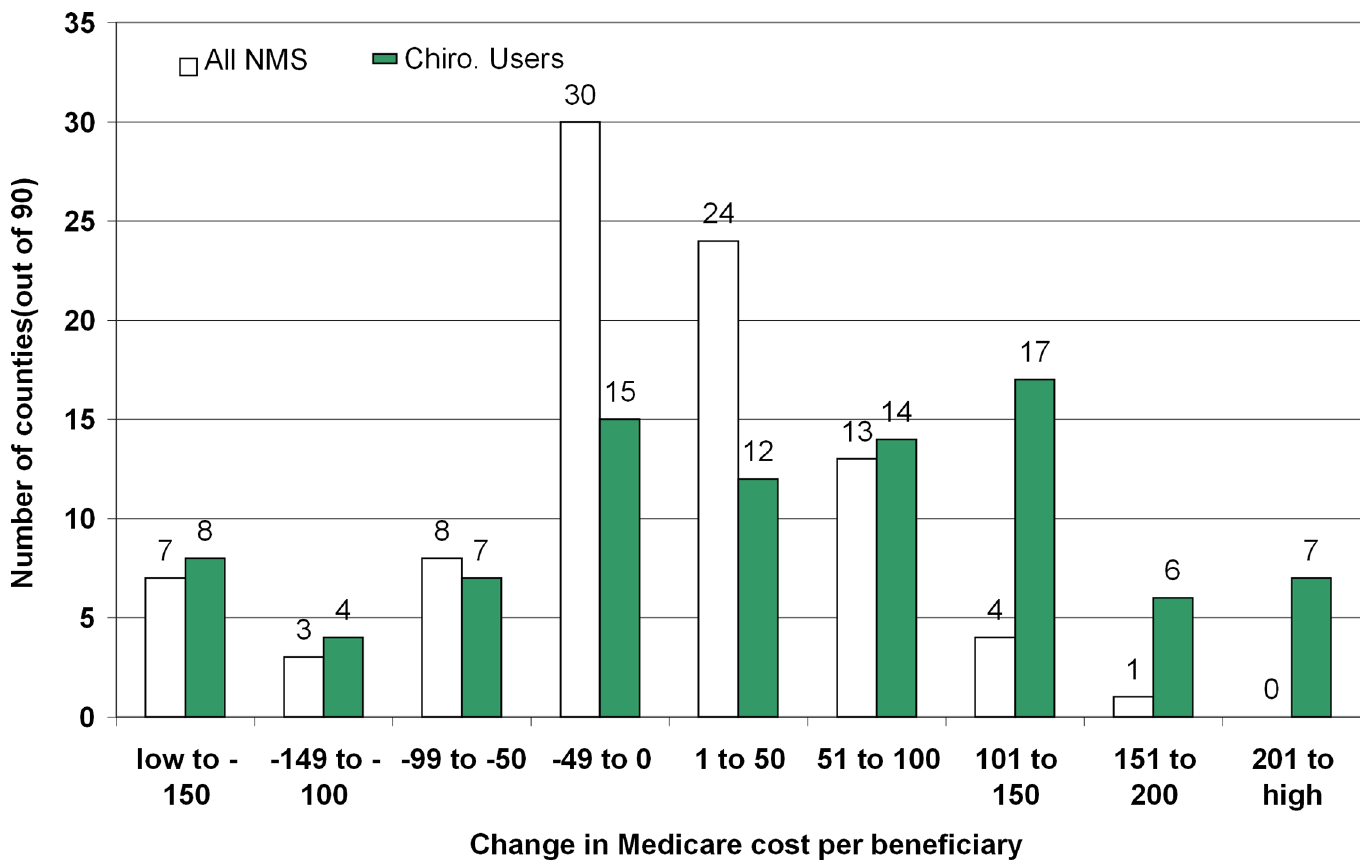
Fig 1. Demonstration Effects on 2-Year Costs per Beneficiary by